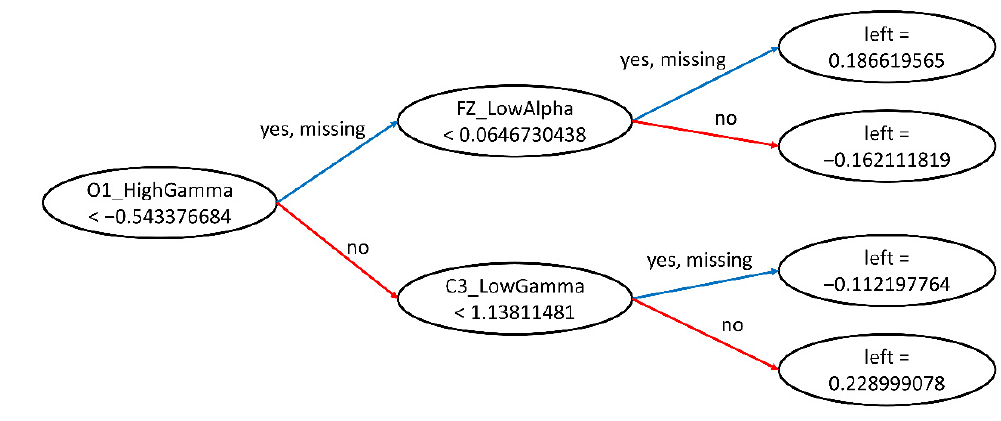
Figure 8. CART visualization.